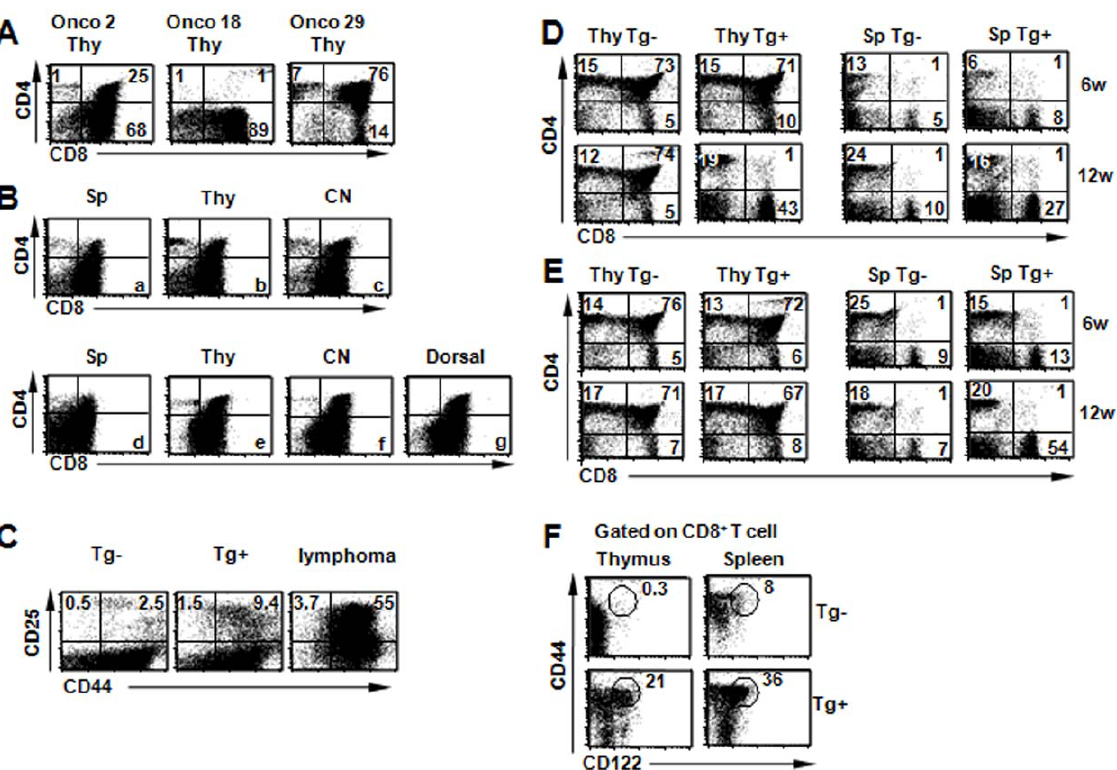
Figure 2. Phenotypes of CD8 + lymphomas and T cell development in NOD.Stat5b Tg mice. (A) Three different types of lymphoma cells are illustrated. The vast majority of lymphomas (57/60) are similar to the Onco 2 mouse, e.g., with CD4 + CD8 + double positive and CD8 + single positive thymocytes. Two mice with lymphomas had predominantly CD8 + single-positive thymocytes (Onco 18) and one mouse had predominantly CD4 + CD8 + double-positive thymocytes (Onco 29). (B) Phenotypes of metastatic tumors. Tumor phenotypes are identical in different lymphoid organs including spleen (SP), thymus (Thy) and cervical lymph node (CN) (a, b, c). Tumor cells (5 6 10 6 ) from thymus of the mouse as shown in b were subcutaneously injected at the back of regular NOD mice. Tumor formation was observed at the site of injection 10–20 days later and tumor cells also migrate to other lymphoid organs including spleen (d), thymus (e) and cervical node (f). Tumor phenotypes are identical at the injection site (g, dorsal) and other lymphoid organs. (C) CD25 expression in thymus of NOD.Stat5b Tg mice and littermate controls at 6 weeks and lymphoma population in cervical node. (D) T cell phenotypes in the thymus (Thy) and spleen (Sp) of NOD.Stat5b Tg mice and littermate controls at 6 weeks (6 w) and 12 weeks (12 w) of age. (E) T cell phenotypes in the thymus (Thy) and spleen (Sp) of NOD/B6 F1.Stat5b Tg mice and littermate controls at 6 weeks (6 w) and 12 weeks (12 w) of age. (F) CD44 and CD122 expression of CD8 + T cells from spleens and thymi of NOD.Stat5b Tg mice (16 weeks of age). Representative data are shown from 1 of 4 similar experiments. not detected in F1.Stat5b Tg mice without lymphoma (Fig. 3a) or with lymphoma (Fig. 3b), consistent with the observations of the low incidence of lymphoma observed in these strains. In contrast, Western blot and FACS analysis detected phosphorylated STAT5 protein at 6 weeks of age and increasing phosphorylation of STAT5 over time in the thymocytes of NOD.Stat5b Tg mice (Fig. 3a& 3d). STAT5 phosphorylation was also detected in lymphoma cells from NOD.Stat5b Tg mice (Fig. 3b).